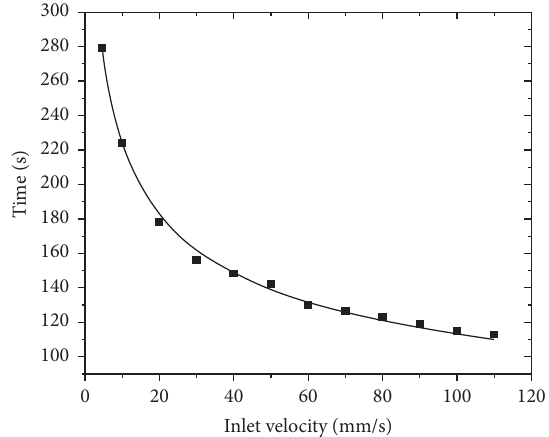
Figure 6: Lysis time over injection